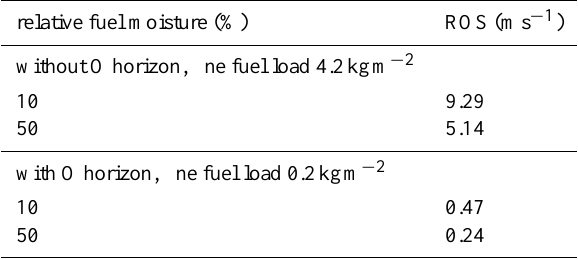
Table 2. Rate of spread (ROS) calculations before and after imple- mentation of the O